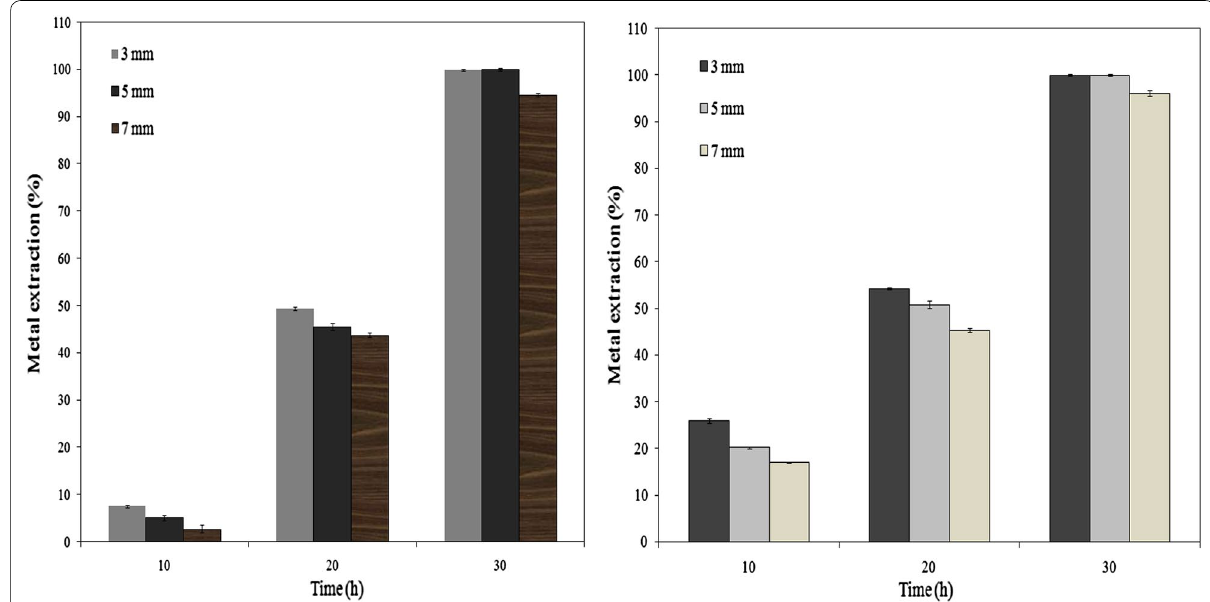
Fig. 5 Effect of particle size of Sn–Cu solder on metal recovery from by 4 ml acetic acid (80%) at 150 rpm shaking speed at 30 °C temperature and 30 h